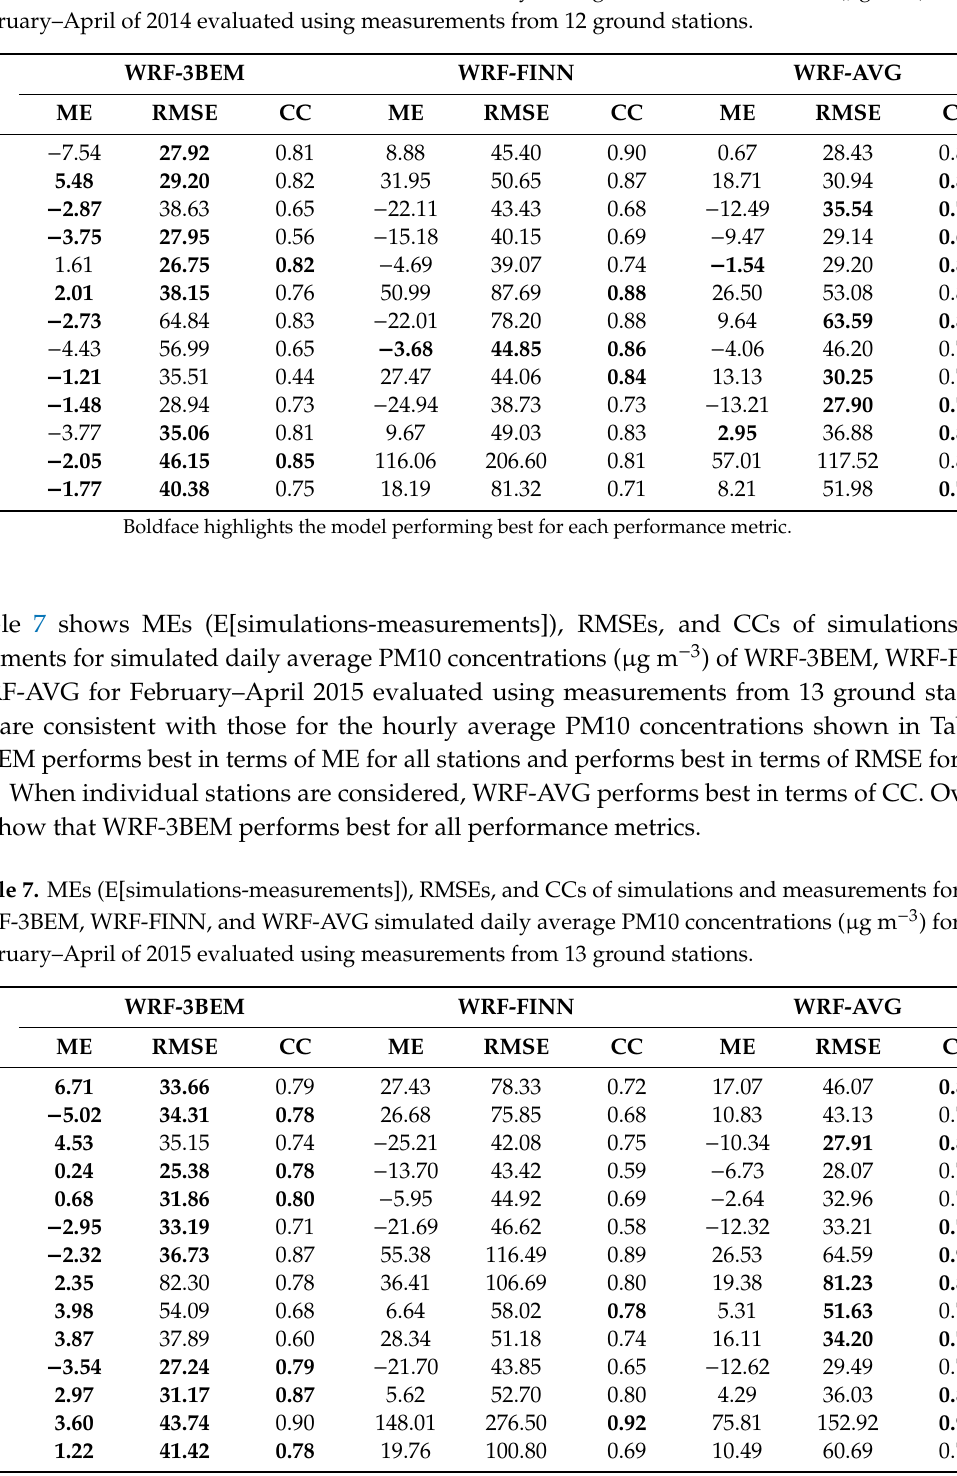
Table 6. MEs (E[simulations-measurements]), RMSEs, and CCs of simulations and measurements for